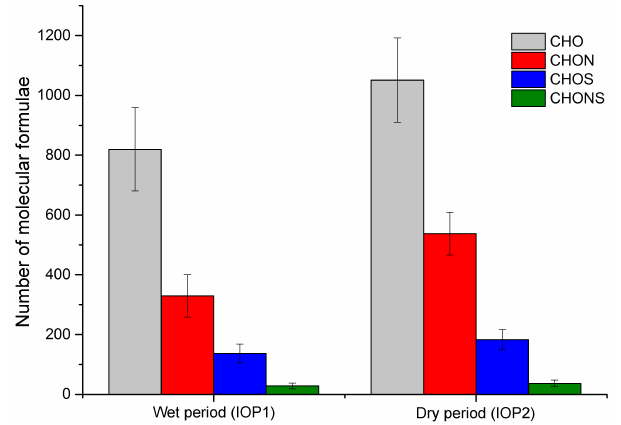
Figure 2. Average number of molecular formulae during IOP1 and IOP2. Standard deviation bars show variations between samples within individual